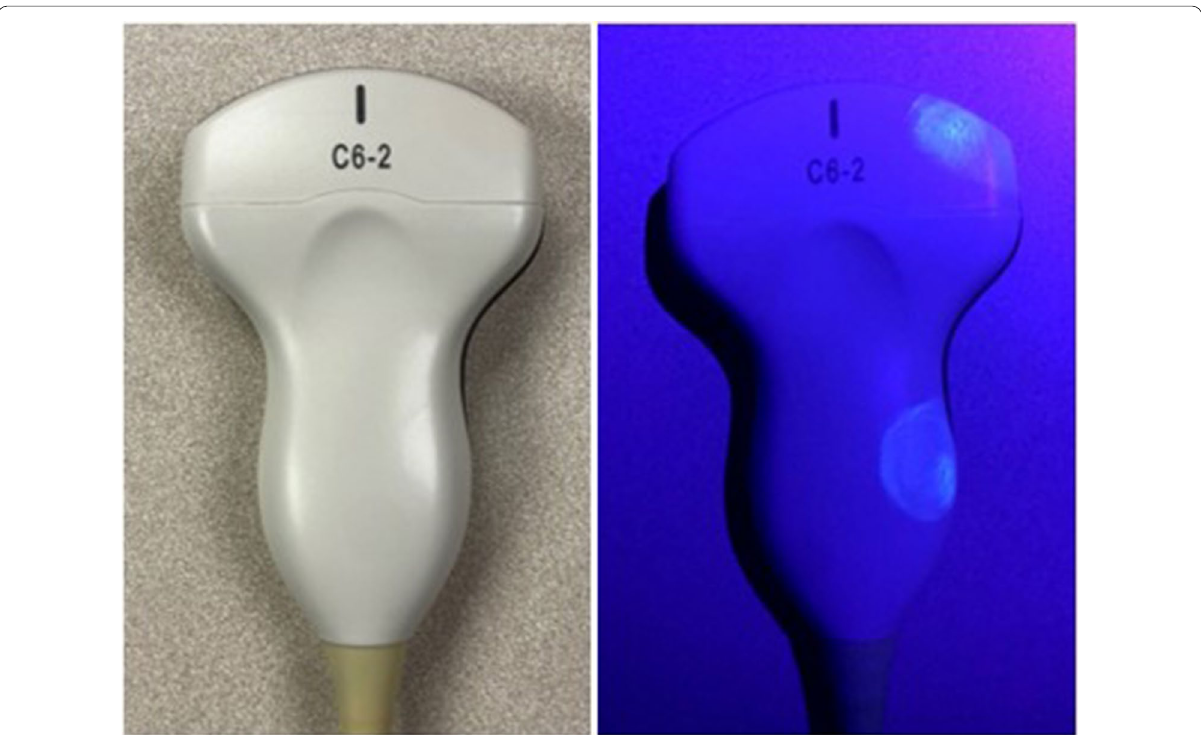
Fig. 2 Fluorescent gel marks. Pictured is a curvilinear probe used to exemplify the size and location of fluorescent marks under ambient room light (left) and UV light with room lights turned off (right)